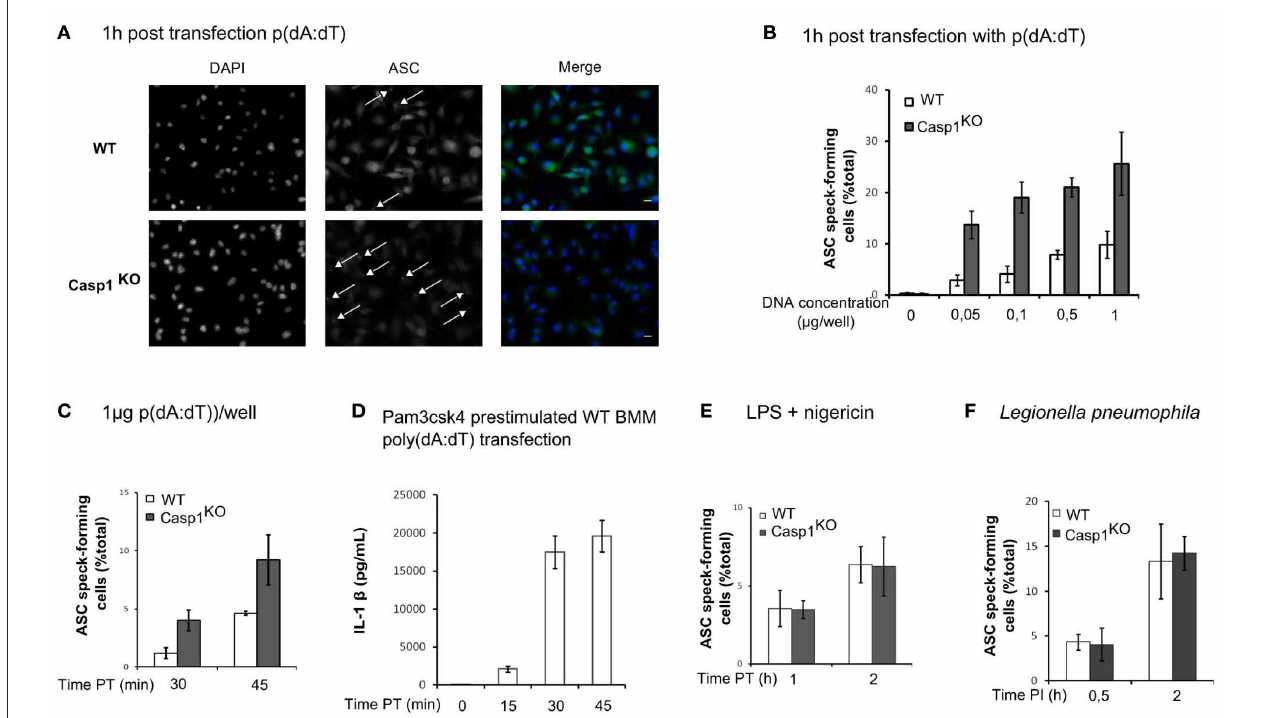
FIGURE 6 | ASC/caspase-1 negative regulation is specific of AIM2 inflammasome. (A–D) BMM were transfected with p(dA:dT). (A) Endogenous ASC was detected by immunofluorescence (scale bar: 10 μ m). ASC speck-forming cells were scored after transfection of a large range of p(dA:dT) concentrations (B) , at different times post transfection with 1 μ g of p(dA:dT) per well (C) , after nigericin (10 μ M) treatment of